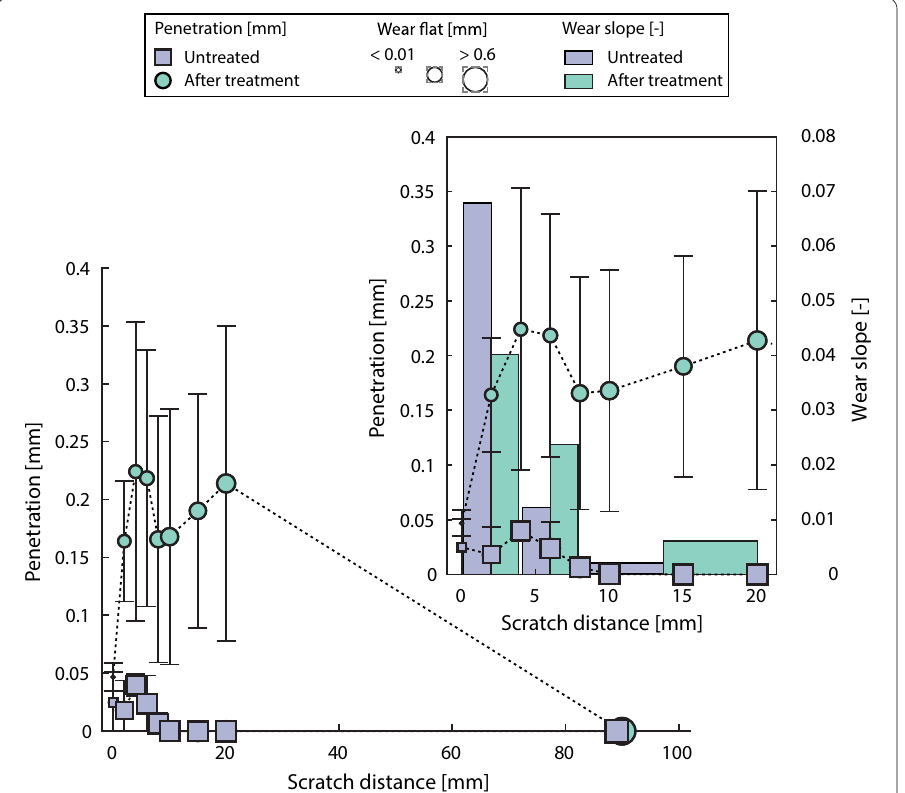
Fig. 4 Tool penetration and wear flat in granite. Tool penetration in Grimsel granite as a function of scratch distance is shown by the scatter plot and the left y -axis for untreated (violet squares) and after-treatment conditions (green circles). The symbol sizes represent the wear flat at the tool tip (see the legend in the figure). An enlargement of the figure for the 0–20 mm scratch distance range is shown in the inset figure. Here, the bar plot shows the wear flat increase per unit of scratch distance, i.e., the wear slope, where the values are given by the right y -axis. Contiguous bar pairs (violet for untreated and green for after-treatment conditions) are shown for the scratch distance ranges 0–4 mm, 4–8 mm and 8–20 mm. The overlapping data points at a scratch distance of 90 mm are shifted along the x -direction to visualize the wear flat (size of